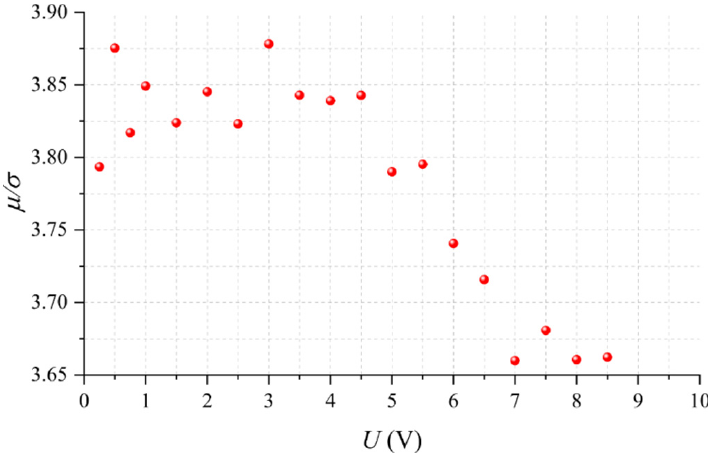
Figure 4. Inverse of the coefficient of variation ( μ / σ ) estimated at different input voltages ( U ) for the 48 sensors under study. Probability fitting to a Gaussian distribution was performed at each U to estimate μ and σ .